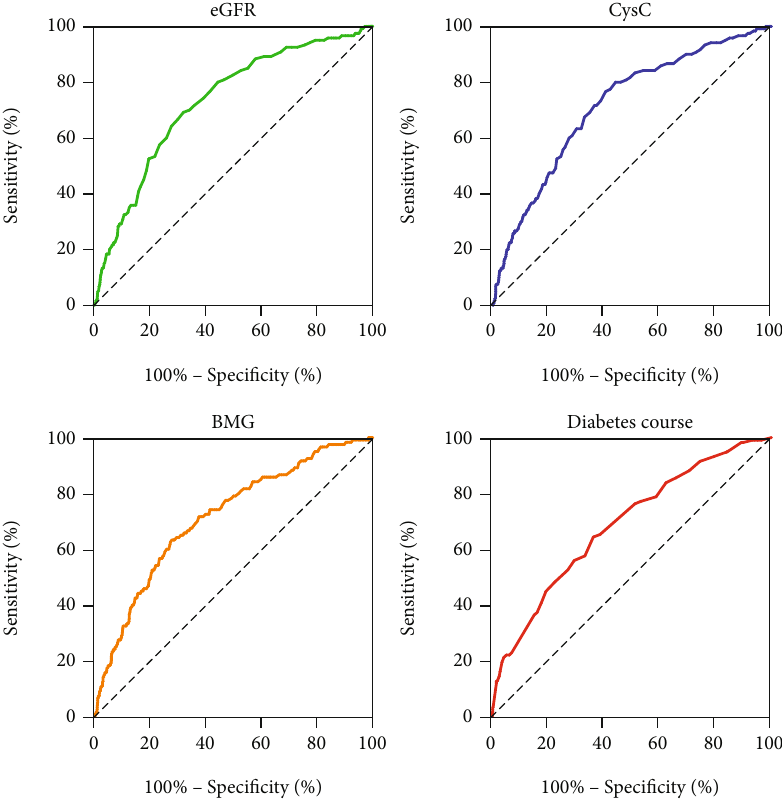
Figure 1: ROC curve of potential risk factors to predict PAD. Abbreviations: ROC: receiver operating characteristic; PAD: peripheral artery disease; eGFR: estimated glomerular fi ltration rate; CysC: cystatin C; BMG: beta 2